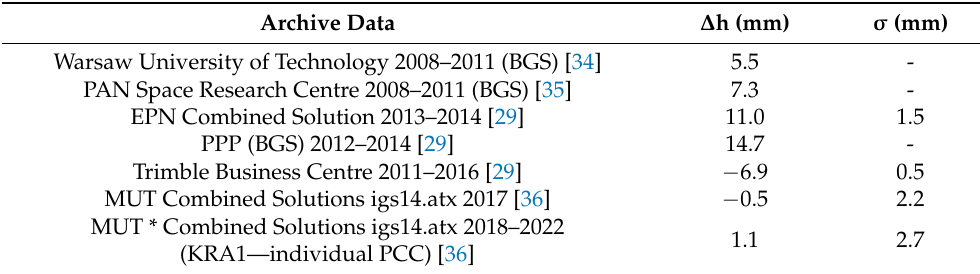
Table 1. Archive values of differences between the KRA1–KRAW stations.